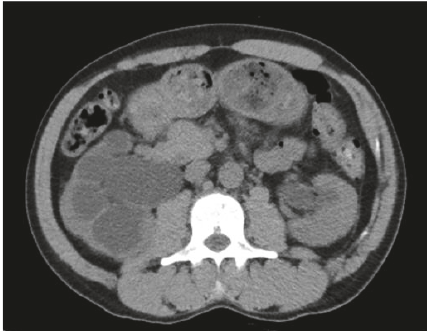
Figure 1: CT scan at the time of admission taken at the level of the kidneys reveals bilateral hydronephrosis, the right greater than the left.